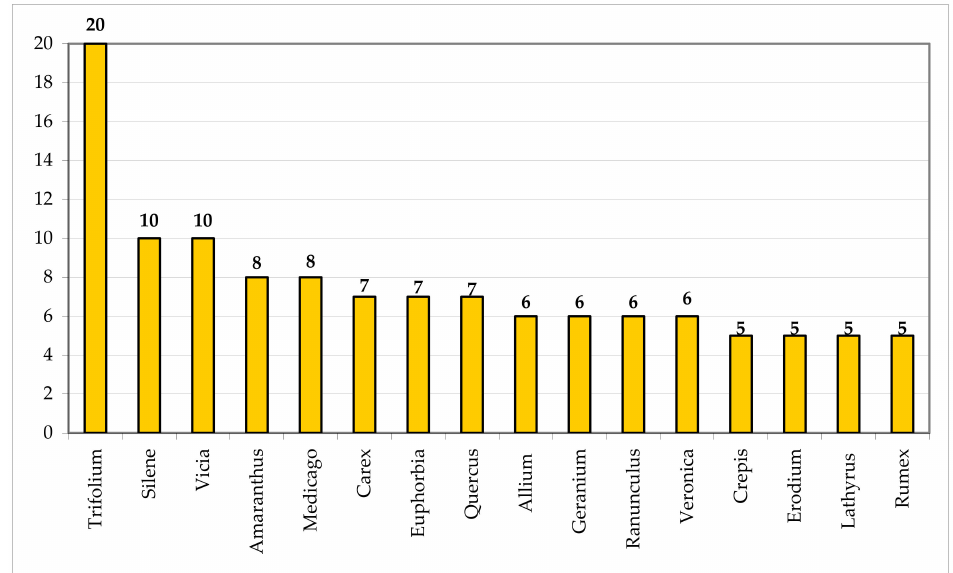
Figure 36. Number of taxa per richest genera [more than four taxa (species and subspecies) per